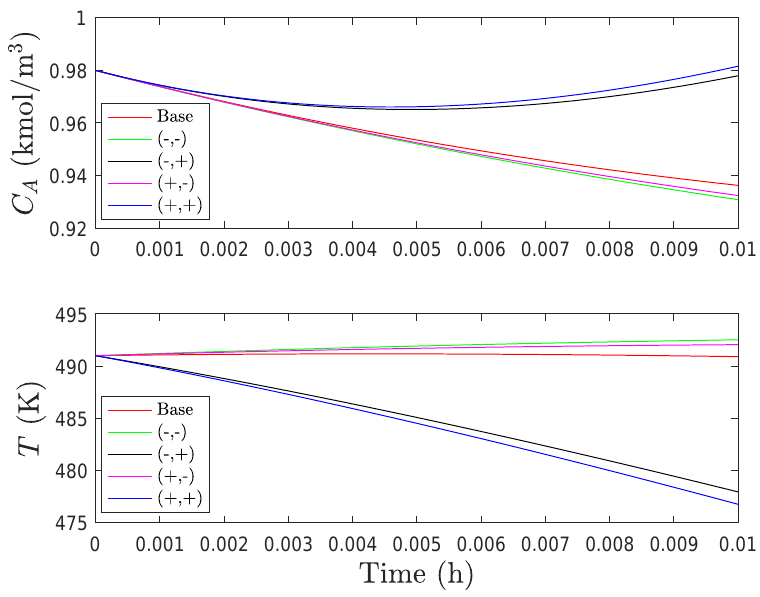
Figure 14. State trajectories for x ( t 0 ) = ( − 0.243 kmol/m 3 , 52.75 K ) and the four cyberattacks.